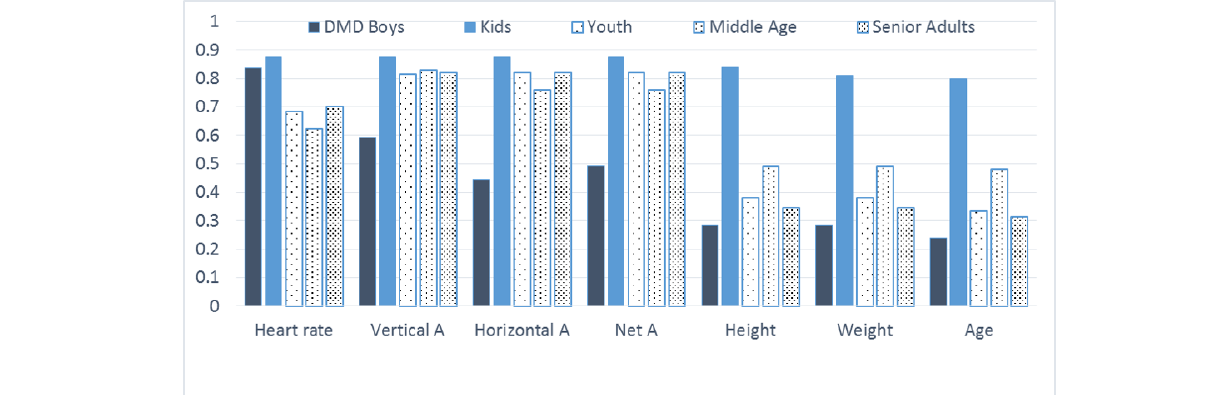
Figure 2. Relative information gain of different attributes on the energy estimation.